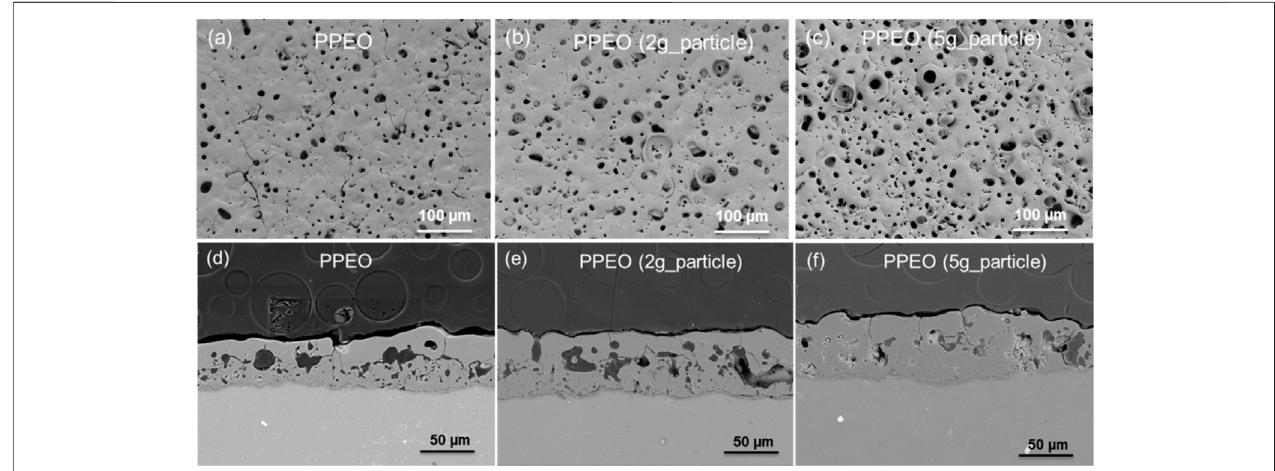
FIGURE 1 | Surface and cross section morphology of the coatings. (A) and (D) PPEO, (B) and (E) PPEO (2 g_particle), (C) and (F) PPEO (5 g_particle).